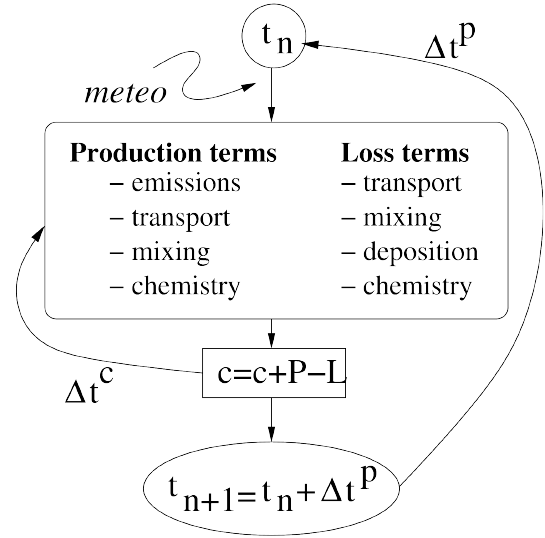
Fig. 4. Principle of “operator-splitting” versus CHIMERE integra- tion In CHIMERE the production and loss terms P and L in equation 2 are replaced by the modified terms ˜ P = P + 300 P h + P v and ˜ L = L + L h + L v , respectively. P h and P v de- note the temporal evolution of the concentrations due to hori- zontal (only advection) and vertical (advection and diffusion) inflow into a given grid box, L h and L v gives the temporal evolution due to the respective outflow divided by the con- 305 centration itself.